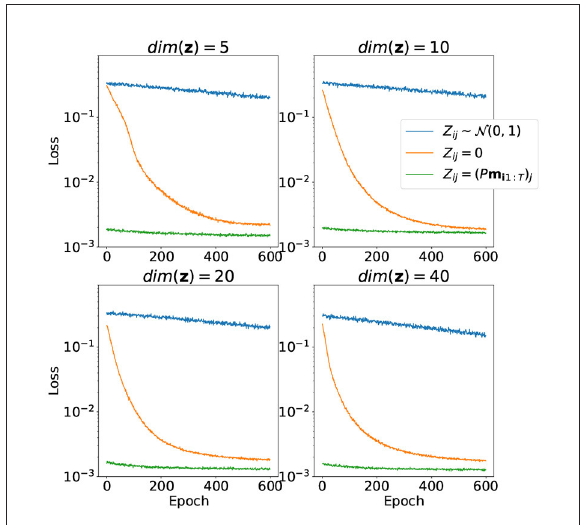
FIGURE5 Convergence of the loss function over 600 training epochs for different ways to initialize matrix Z and different dimensions of z. Only matrix Z is trained, model parameters θ are fixed.